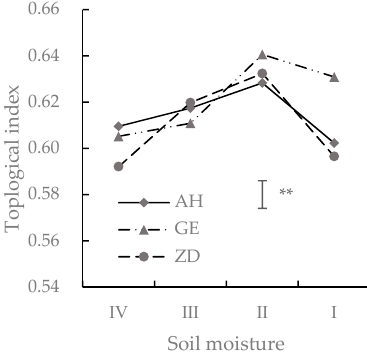
Figure 3. Interaction on topological index between cultivars (AH, GE and ZD) and soil moisture (See Figure 2 for soil moisture abbreviations). ** p < 0.01. Table 2. Mean topological index (TI) under various soil moisture (See Table 1 for soil moisture abbreviations) and cultivar (AH, GE and ZD) treatments. * p < 0.05; ** p < 0.01.